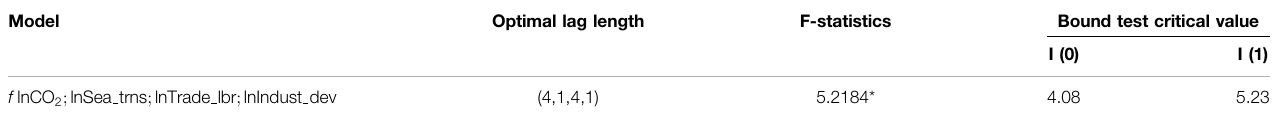
TABLE 5 | ARDL bound test results of China.